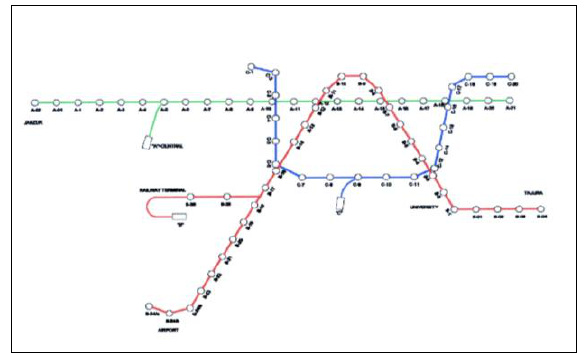
Figure 1. Schematic representation of Tripoli Metro Network